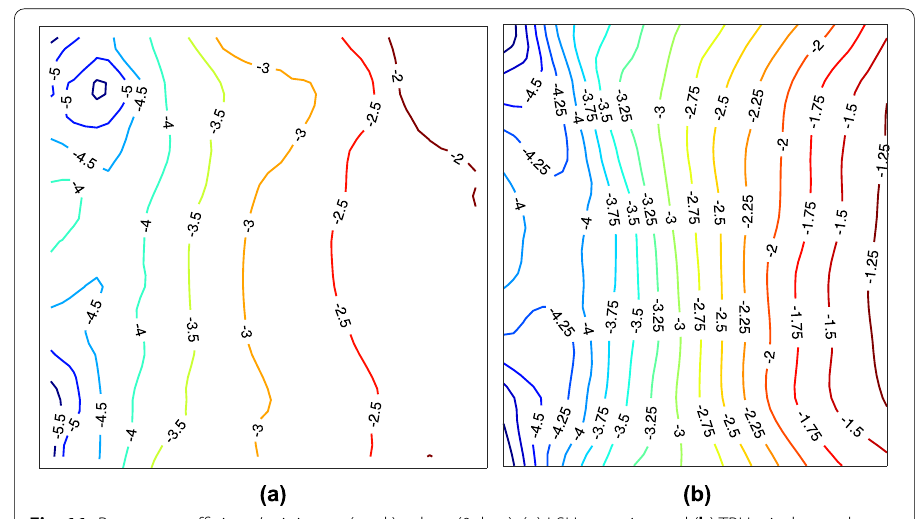
Fig. 11 Pressure coefficients’ minimum (peak) values (0 deg.): ( a ) LSU open-jet, and ( b ) TPU wind tunnel (wind from left to